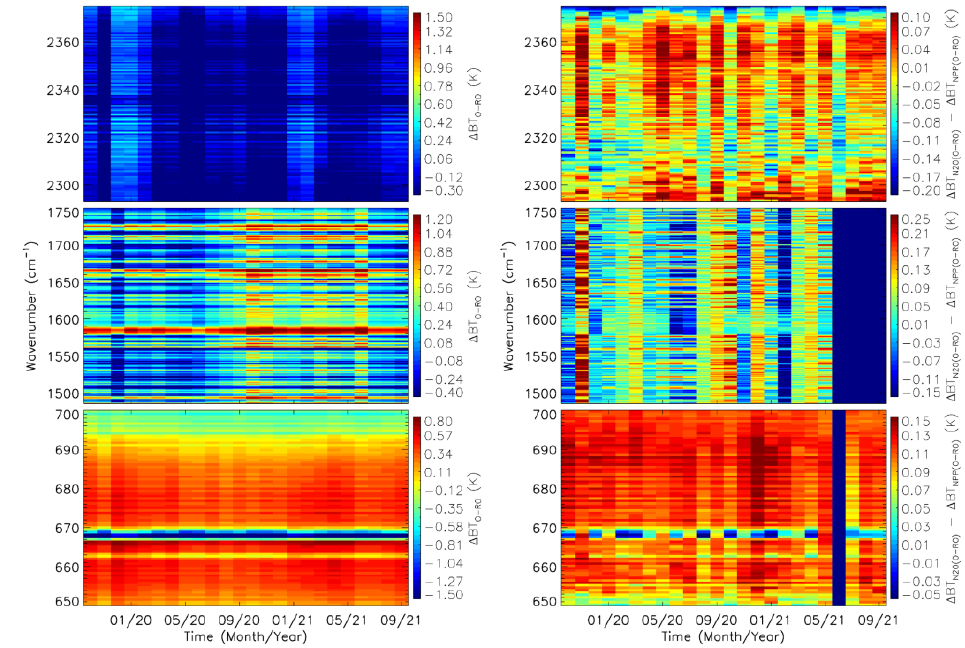
Figure 14. Same as Figure 12, except for results from the nighttime. Figure 12 shows the monthly mean BT difference between NOAA-20 CrIS observations and simulations with UCAR RO data (left panel) and two CrIS double differences between NOAA-20 and S-NPP using simulations with UCAR RO data as a transfer (right panel) for all the collocated clear radiance data. Note that the data gaps in the LWIR band during June 2021 and the MWIR band after June 2021 are due to S-NPP CrIS electronics failure. S-NPP CrIS operated on the Side-2 electronics after 24 June 2019, when the MWIR band failed on Side 1 [48]. From 21 May to 12 July 2021, the LWIR band failed on Side 2. After 12 July, CrIS on S-NPP was switched back to side 1, and there are no MWIR SDR data available. Compared to results from the MWIR and SWIR bands, the time series of the monthly mean BT difference from the channels in the LWIR band is much smoother, with a smaller month-to-month variation. For channels 1 to 66 with wavenumber 650 cm −1 to 690.625 cm −1 , the BT differences show positive values (less than 0.8 K), except for chan- nel 21 (662.5 cm −1 , with WFPH 26.76 km) and channels 28 to 33 (wavenumber from 666.875 cm −1 to 670.0 cm −1 with WFPHs as 21.39, 41.80, 40.13, 32.27, 27.56, and 23.86 km, respec- tively) with negative mean values. The most significant negative BT (above − 1.5 K) oc- curred in channel 29, with the highest WFPH over 41.80 km and a significant radiance contribution from above 60 km, where no temperature information is provided in the WETPf2 product. For channels 67 to 81 (wavenumber 691.250 cm −1 to 700.0 cm −1 ), the BT difference shows negative values and can be as large as − 0.6 K. As discussed in the previ- ous section (see Figure 7), the majority of the BT difference can be explained by the use of default CO 2 concentrations in the forward simulation. Supposing that we use a more re- alistic CO 2 profile in the simulation, in that case the BT difference can be significantly re- duced to within ±0.2 K during this two-year comparison period for those channels with WFPHs from 12 km to 20 km and covering the atmosphere from 7 km to 40 km. The com- parison results from those CO 2 temperature sounding channels in the LWIR band indicate that the temperature profiles retrieved from the COSMIC-2 observations are very accurate (within ±0.2 K) and can be used as independent and reference data source to evaluate the infrared sensors. The BT differences from the MWIR water vapor channels (1155 to 1578) in the 1485.625 – 1750 cm −1 region not only show large channel-to-channel variation (due to the